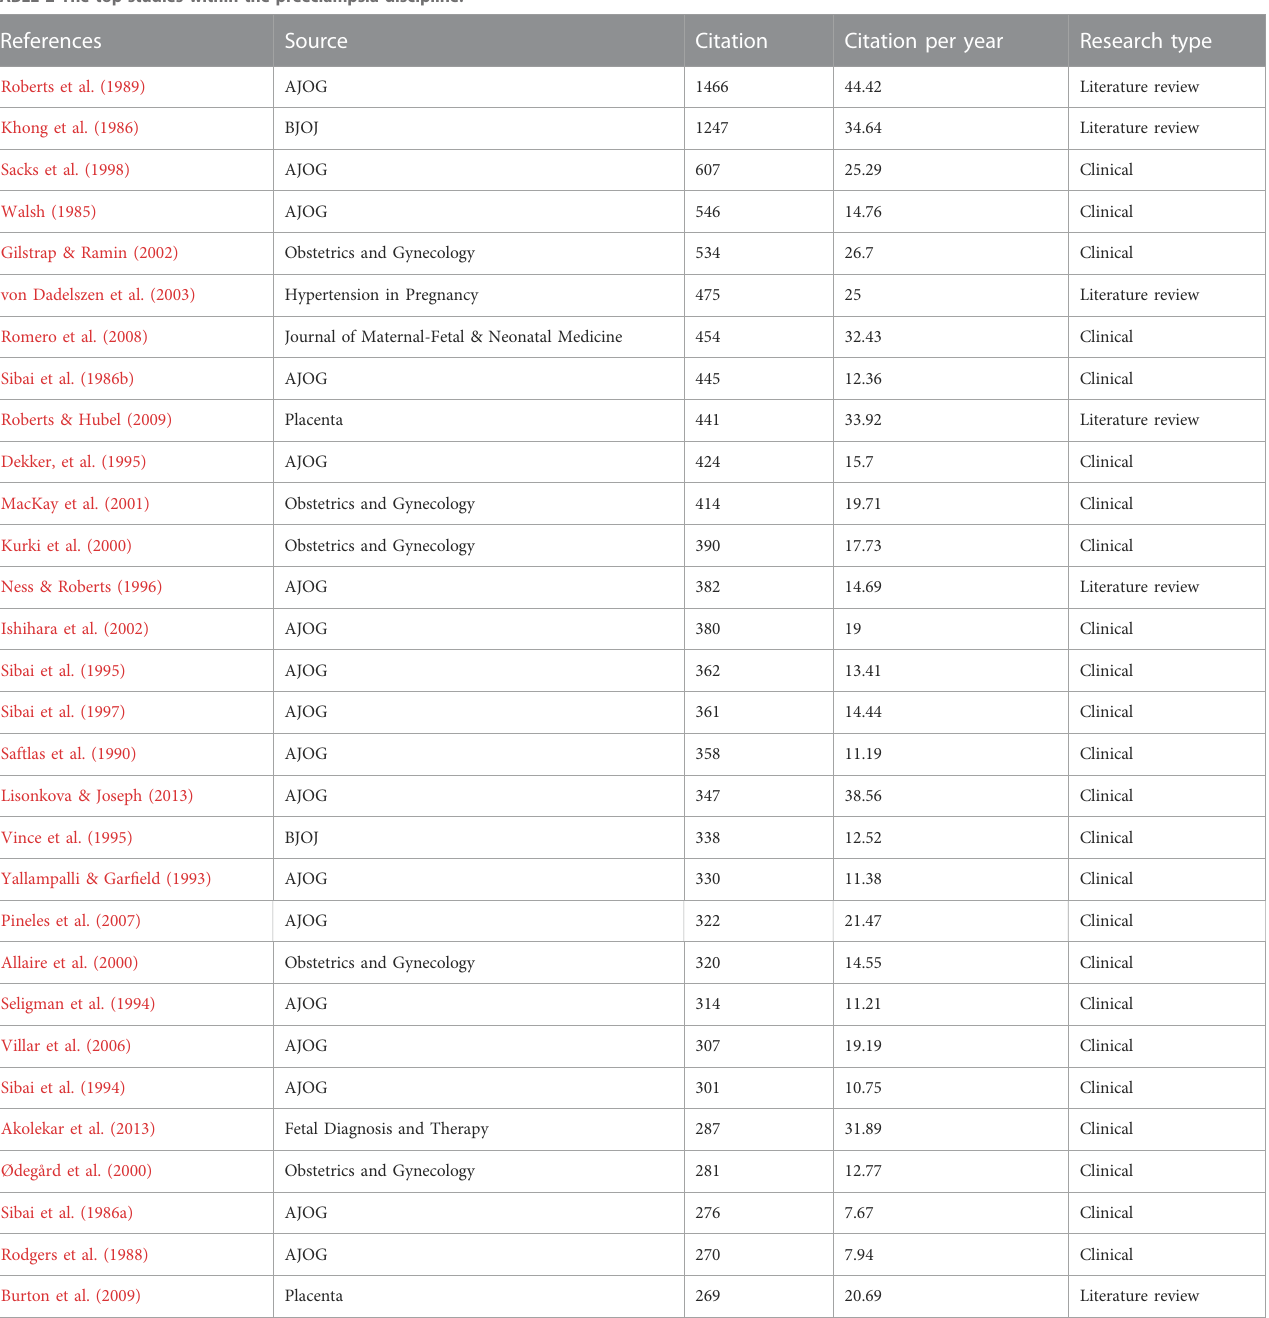
TABLE 2 The top studies within the preeclampsia